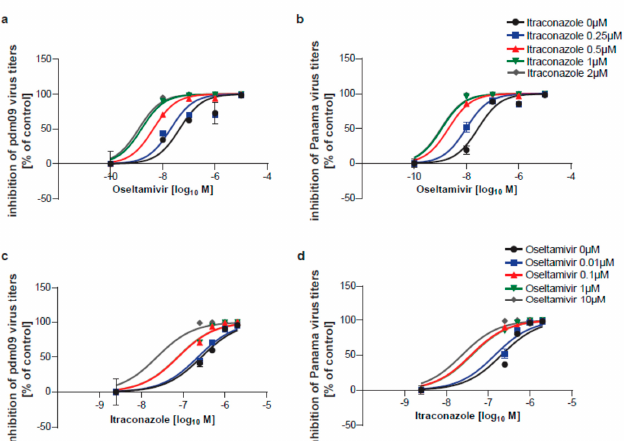
Figure 5. Analysis of the anti-IAV activity of oseltamivir and itraconazole in combinatory treatments. Polarized Calu-3 monolayers were infected with 0.1 MOI of ( a , c ) pdm09 or ( b , d ) Panama for 24 h. At 2 h p.i. cells were treated with combinations of oseltamivir and itraconazole at the indicated concentrations for 16 h. Data represent mean percentages ± SEM of inhibition, with mean virus titer in control cells (treated with the solvent DMSO) set to 100%; n = 3. LogEC 50 values were determined by fitting a non-linear regression model and were compared for shared logEC 50 values. Generally, virus titers were potently reduced for all treatments and both virus subtypes. Individually applied, 10 µM oseltamivir was required to achieve ≥ 90% reduction of maximum virus titers produced in control cells, and 1 µM itraconazole was already sufficient to yield a similar reduction (Figure 6). Combinations of 0.5 µM itraconazole with either 0.1 or 1 µM oseltamivir had an inhibitory effect of ≥ 90%, which was not seen when the drugs were given individually.